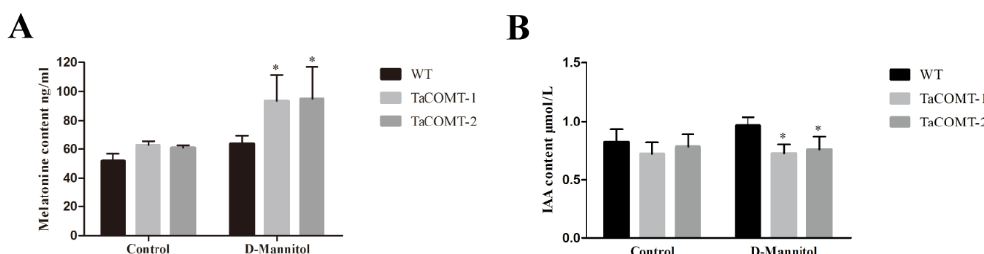
The content of MDA in TaCOMT -overexpression lines were 39.15 and 38.25 nM/g, respectively, which were significantly lower than that of WT (56.98 nM/g) (Figure 4C). These results suggested that overexpression of TaCOMT maintains intracellular osmotic balance and reduces cell membrane damage, which contributed to drought tolerance of transgenic Arabidopsis . We also analyzed the melatonin content in WT and transgenic lines. The results showed that, under normal conditions, the melatonin content of transgenic lines TaCOMT -1 and TaCOMT -2 were 62.63 and 60.84 ng/mL, respectively, which were slightly higher than the 51.88 ng/mL in WT (Figure 5A). Under D-Mannitol treatment, the melatonin content of transgenic TaCOMT -1 and TaCOMT -2 were 86.84 and 95.01 ng/mL, respectively, which were significantly higher than the 60.54 ng/mL in WT ( p < 0.05) (Figure 5A). These data indicating that overexpression of TaCOMT increased biosynthesis of melatonin in transgenic Arabidopsis under drought stress. In addition, we detected the content of IAA in WT and transgenic lines under normal and D-Mannitol treatment. Under normal conditions, the content of IAA of transgenic lines TaCOMT -1 and TaCOMT -2 were 0.72 and 0.77 µ mol/L, respectively, which were slightly lower than the 0.81 µ mol/L in WT. Under D-Mannitol treatment, the IAA content of transgenic lines ( TaCOMT -1 and TaCOMT -2) were 0.70 and 0.73 µ mol/L, respectively, which was significantly lower than that of WT lines (0.65 µ mol/L) ( p < 0.01) (Figure 5B).